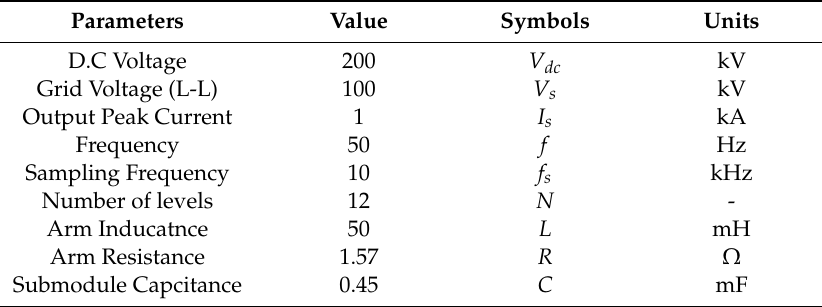
Table A1. Modular multilevel converter (MMC)